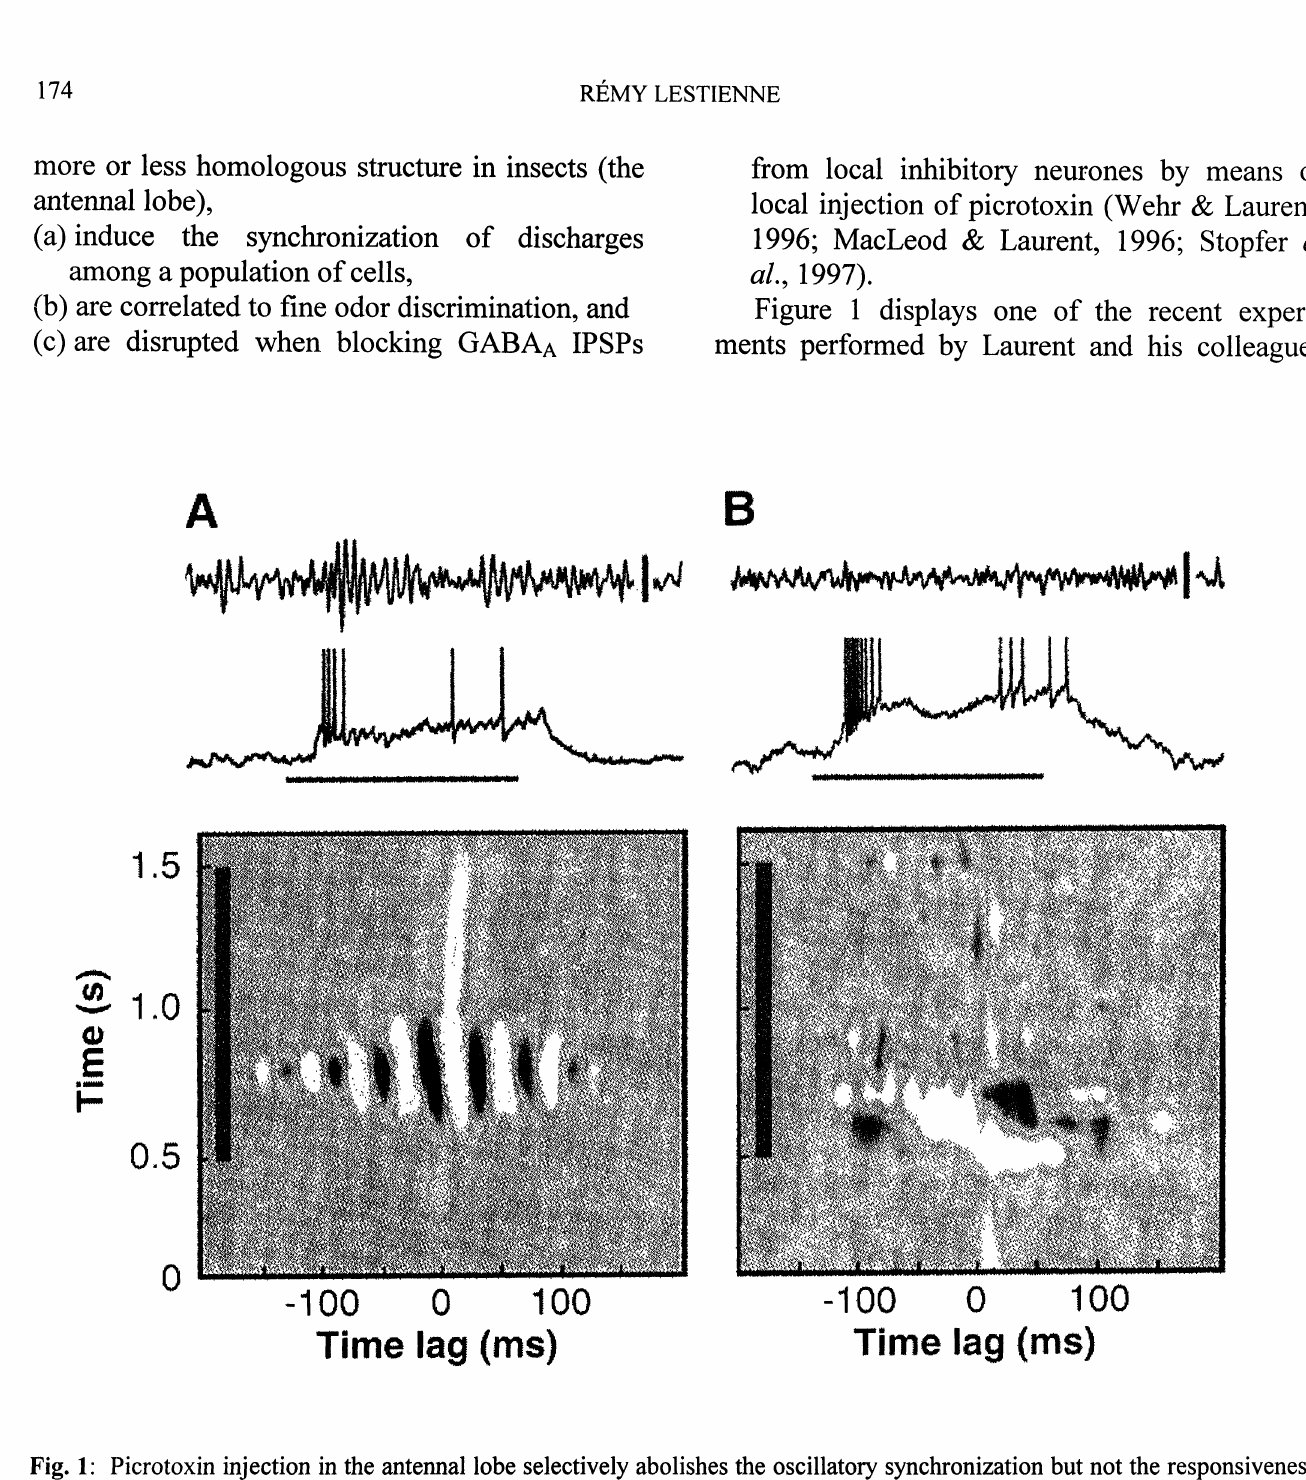
Fig. 1" Picrotoxin injection in the antennal lobe selectively abolishes the oscillatory synchronization but not the responsiveness of Principal Neurones (PN). Top traces: LFP from mushroom body. Middle traces: simultaneous intracellular recording from antennal lobe PN during odor puff (indicated by horizontal bar). Bottom: sliding cross-correlation between LFP and PN traces. Only the relative (and not the absolute) values of the cross-correlation functions matter. A: Control response to mint odor. The biphasic PN response and the prominent IPSPs are apparent during the odor response. The oscillatory LFP indicates synchronized and rhythmic firing of many other PNs during the odor response. The cross- correlation between PN and LFP shows a striped pattern with -50 ms period during the first half of the odor puff (vertical bar between 0.5 and 1.5 s), indicating an odor-evoked transient synchronization between this PN and the LFP. B" same pair as in A, 2 min after pressure injection of 800 laM of picrotoxin into the antennal lobe. Although the response pattern of the PN to mint is not qualitatively altered (the period of initial excitation, suppression, and subsequent excitation are preserved), the IPSPs have disappeared (indicating the block of LN mediated fast inhibition ), and the 20 Hz LFP oscillation are abolished. The cross-correlation is aperiodic (Modified from MacLeod and Laurent,